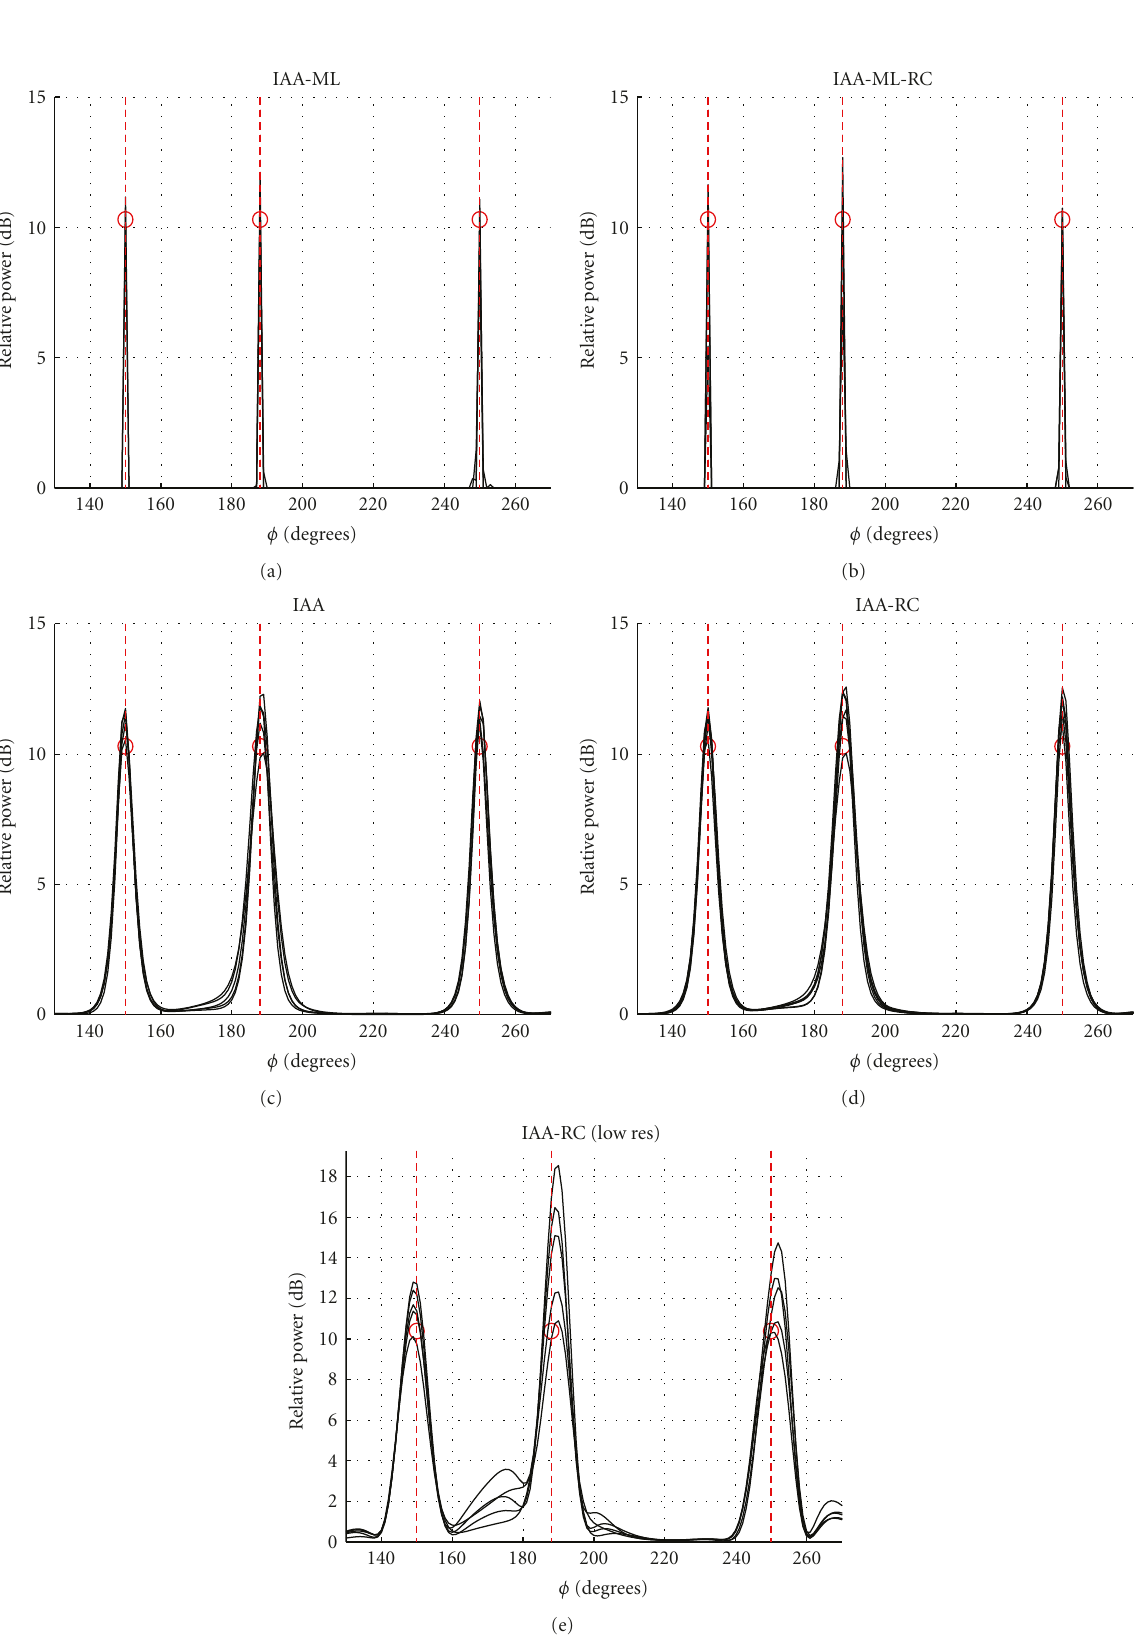
Figure 3: Spatial estimates of the di ff erent beamforming solutions (rectangular array, θ 1 = 45 ◦ , φ 1 = 150 ◦ , θ 2 = 45 ◦ , φ 2 = 188 ◦ , θ 3 = 45 ◦ , φ 3 = 250 ◦ , N = 10 snapshots, SNR 1 = SNR 2 = SNR 3 = 10 dB, noise power equal to 0dB, and f c =